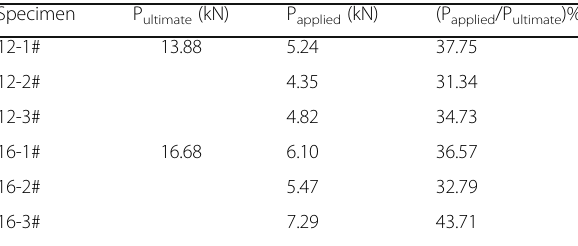
Table 1 Theoretical ultimate load and applied load when visible crack occurs for each specimen